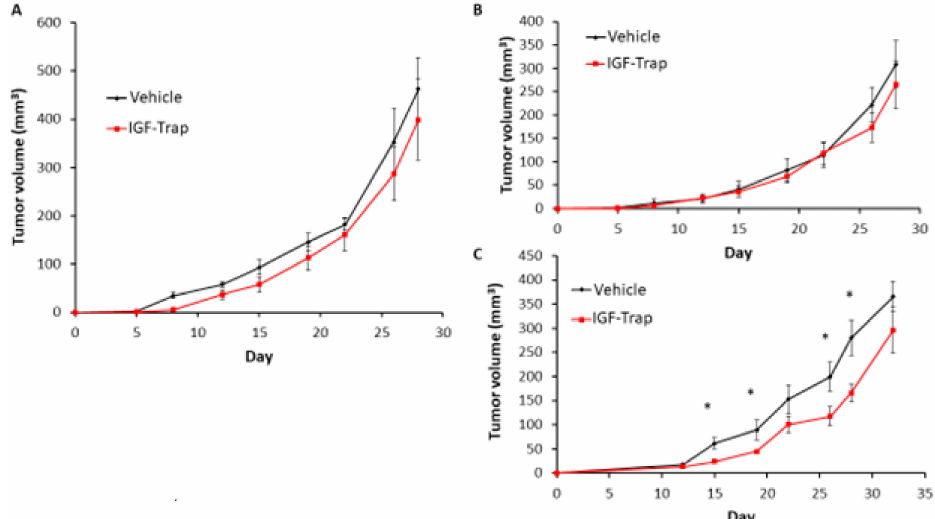
Figure 9. FGFR1 silencing increases the sensitivity of MDA-MB-231-R cells to IGF-Trap treatment in vivo. FGFR1-silenced MDA-MB-231-R cells in Matrigel were injected into the mammary fatpads of female NSG mice and the mice treated, twice weekly, with 5mg/kg IGF-Trap, intravenously. Tumor volumes were recorded twice weekly. Shown are mean tumor volumes ( ± SE) in mice injected with wild type ( A ), control transfected ( B ) and FGFR1 silenced ( C ) MDA-MB-231-R cells ( n = 5). Note the initial delay in tumor appearance in mice injected with FGFR1 silenced MDA-MB-231 cells. * p < 0.05 as analyzed by the Student’s t